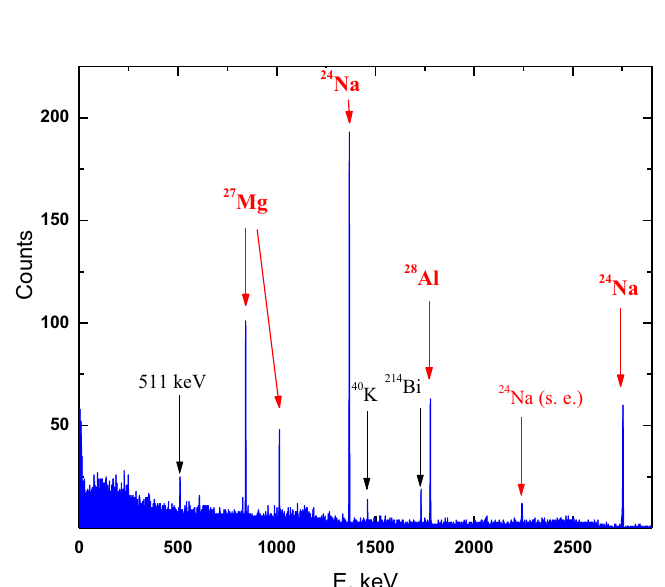
Figure 4. Energy dependent gamma ray spectrum of Al sample activated in the Central channel of the Pu-Be neutron sources. Al sample measurement time is 2477s. Table II. The comparison of modeled and experimentally estimated reaction rates (R) of the neutron activation in the samples in the Central channel of the neutron storage